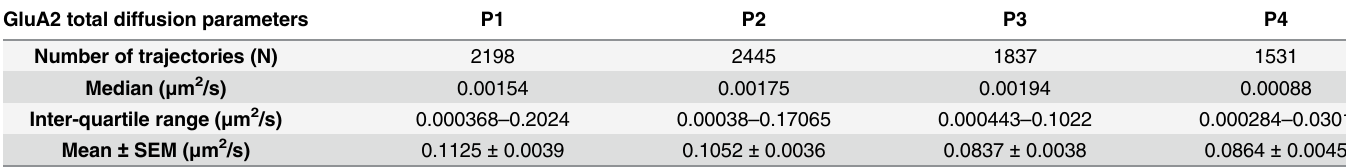
Table 2. Absolute values of surface GluA2 AMPA instantaneous diffusion coefficients prior to the 4 corticosterone pulses. The diffusion coefficient is expressed in μ m 2 /s (see Methods for calculation) and was obtained in live cultured hippocampal neurons of at least 10 days in vitro . GluA2 total diffusion